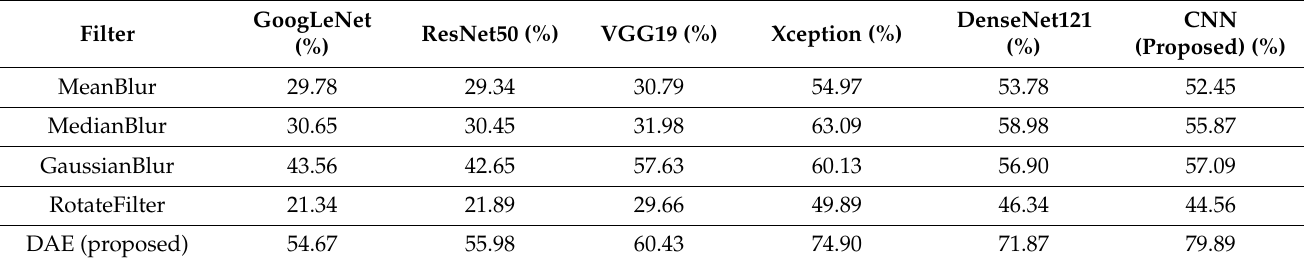
Table 7. Comparison accuracy results, defending against the MI-FGSM attack using the image processing filters with the transfer learning models compared to the proposed DAE-CNN model, based on the testing